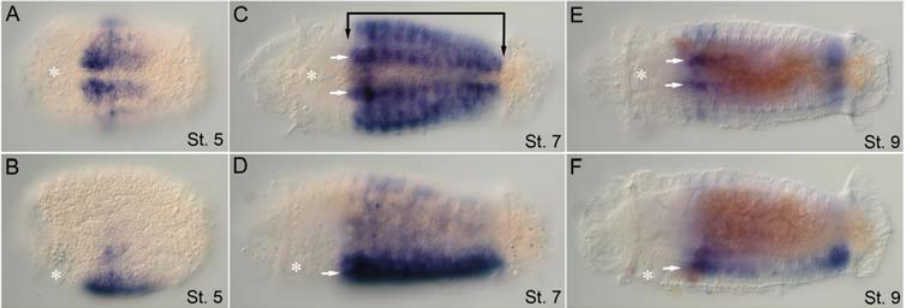
Figure 6. CapI-Dfd larval expression patterns. Anterior is to the left for all panels. Stages are written at the bottom right of each panel. (A), (C), and (E) show ventral views; (B), (D), and (F), lateral views. Asterisk marks position of the mouth. (A, B) At late stage 4, there is ventral ectodermal expression along the medial border of the belly plates. (C, D) At stage 7, expression includes the VNC (white arrows) and lateral ectoderm from T2 to the telotroch. (E, F) Expression is most prominent in the VNC of T2 (white arrows) and in the posterior-most segments and growth zone. Low levels of body epidermis expression persist.